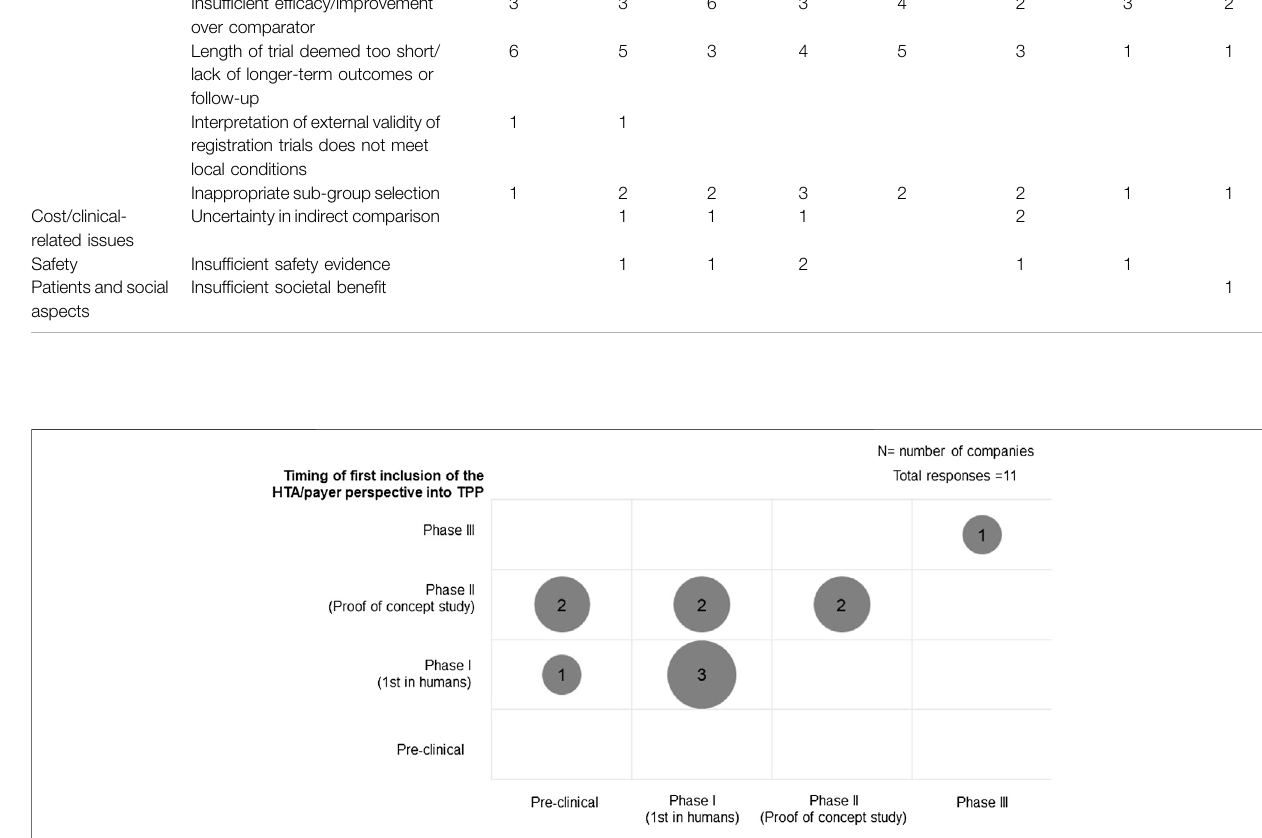
Frontiers in Pharmacology |